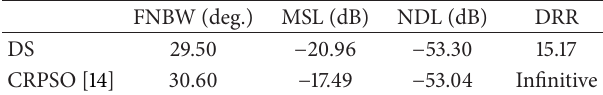
Table 2: FNBW, MSL, NDL, and DRR values obtained by DS and CRPSO [14] for the second example (16 elements).